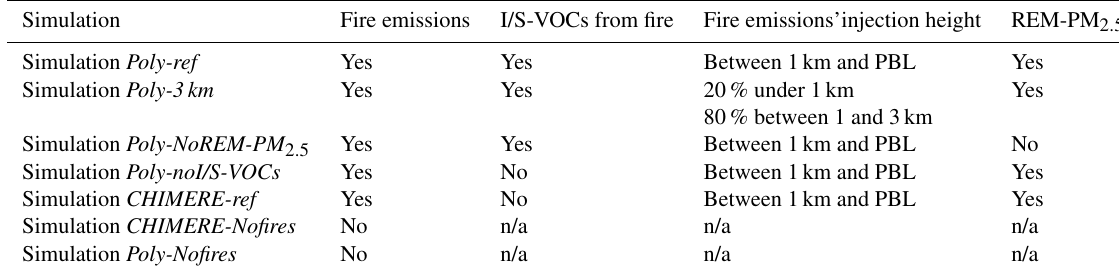
Table 2. Summary of the configurations used in different simulations. n/a – not applicable. Simulation Fire emissions I/S-VOCs from fire Fire emissions’injection height REM-PM 2 . 5 Simulation Poly-ref Yes Yes Between 1km and PBL Yes Simulation Poly-3km Yes Yes 20% under 1km Yes 80% between 1 and 3km Simulation Poly-NoREM-PM 2 . 5 Yes Yes Between 1km and PBL No Simulation Poly-noI/S-VOCs Yes No Between 1km and PBL Yes Simulation CHIMERE-ref Yes No Between 1km and PBL Yes Simulation CHIMERE-Nofires No Simulation